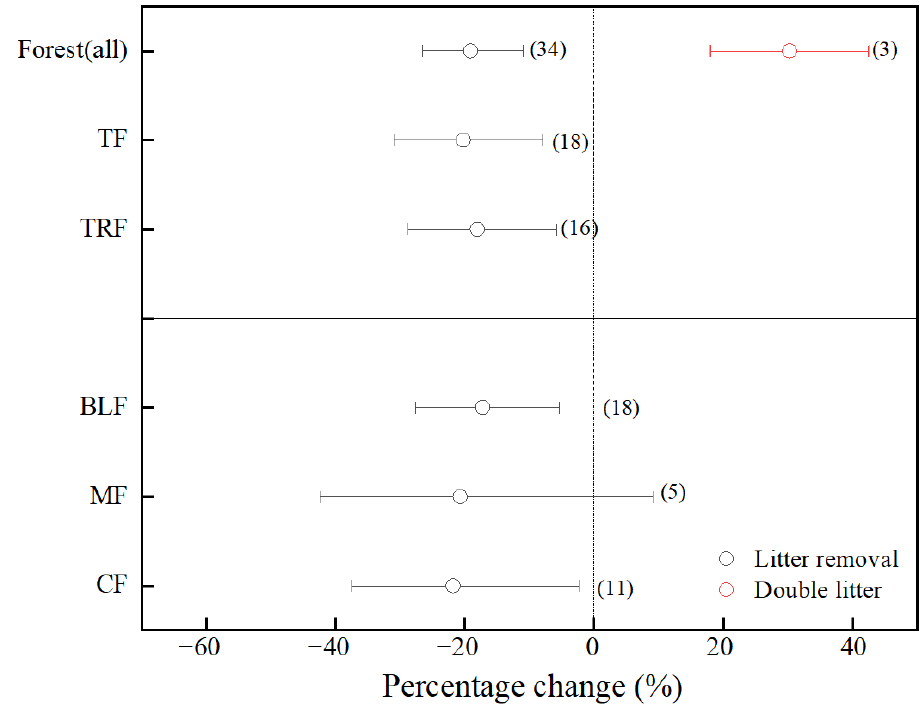
Figure 1. Effects of litter removal or a doubling of litter inputs on soil N 2 O fluxes for different forest ecosystem types. Horizontal lines represent the 95% confidence intervals (CI) and the numbers of observations are included in parentheses. The means were considered significantly different if their 95% CI did not overlap with zero. TRF, tropical forest; TF, temperate forest; BLF, broad-leaved forest; MF, mixed forest; CF, coniferous forest.